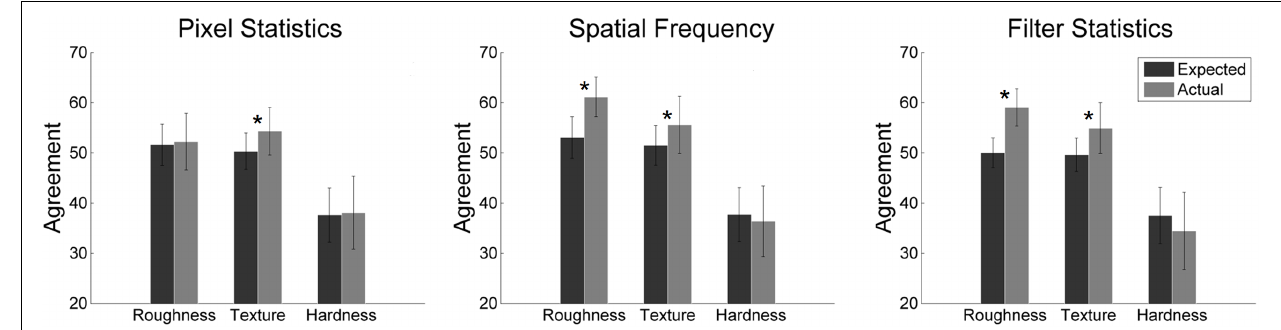
FIGURE 6 | Summary of the two classifiers’ (image statistics and MVPA) actual vs. expected agreement for the three different image statistic groups. Error bars indicate standard deviations; asterisks indicate statistical significance ( p < 0.05).